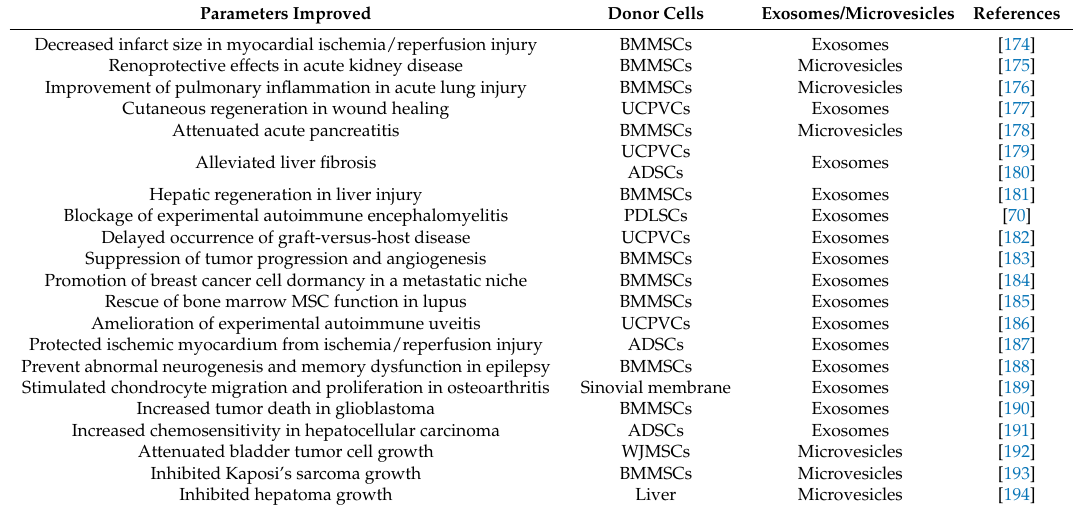
Table 2. Beneficial effects of MSC-derived exosomes and